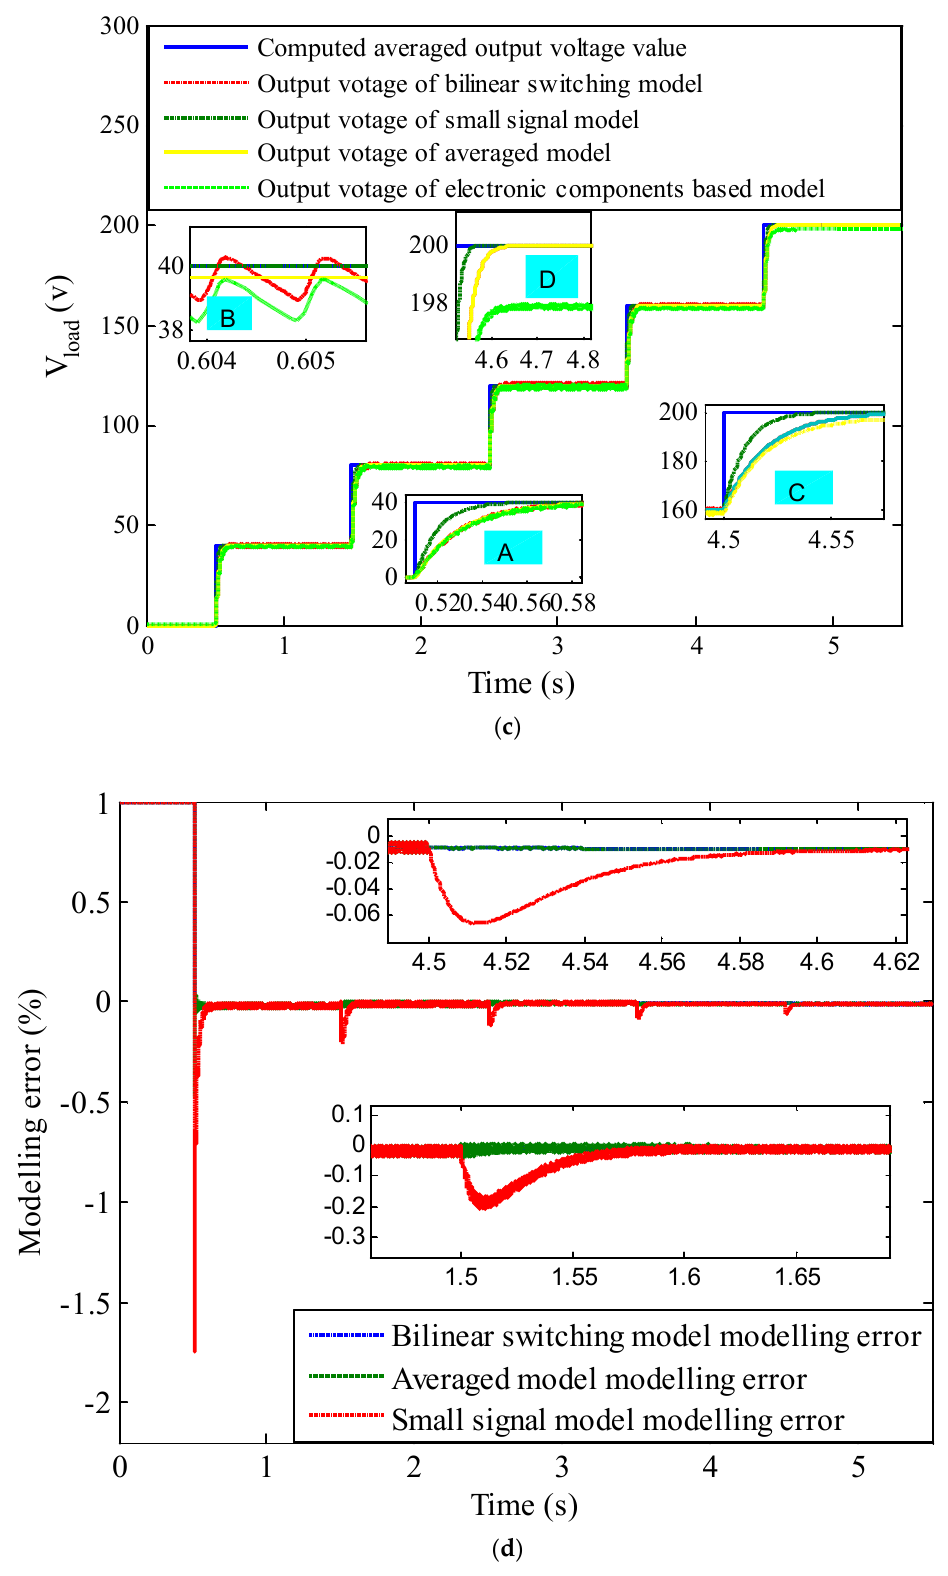
Figure 2. Comparative study simulation results: ( a ) duty cycle, ( b ) control signal, ( c ) output voltages of DC-DC buck converter models and ( d ) model modeling error.